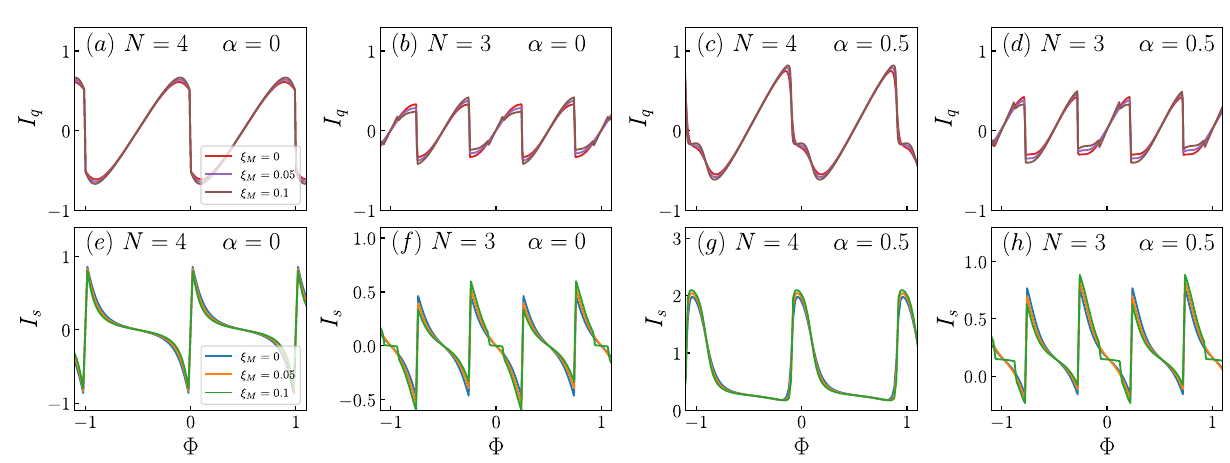
Figure 6. Charge and spin persistent currents, I q and I s respectively, for (cid:31) 1 = 0.1, (cid:31) 2 = 0.15 . The number of sites, N , and the Rashba spin-orbit coupling, α , are indicated in the figures. The coupling between MZMs, ξ M , is indicated by coloured lines, shown in the leftmost